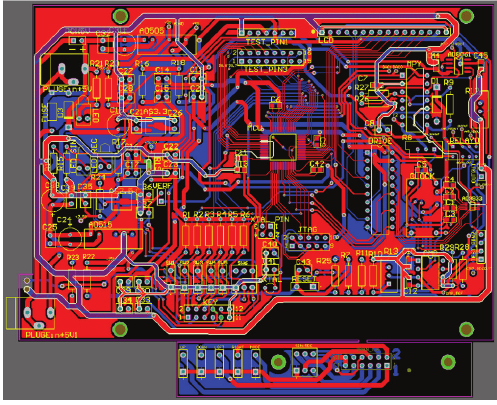
Figure 15: The whole PCB design